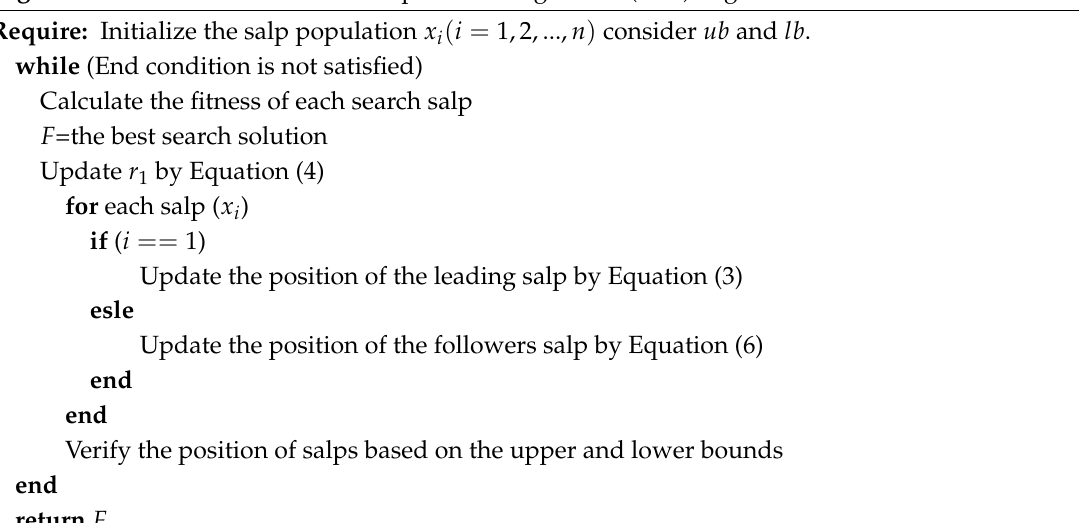
Algorithm 1 The Procedure of the Salp Swarm Algorithm (SSA)